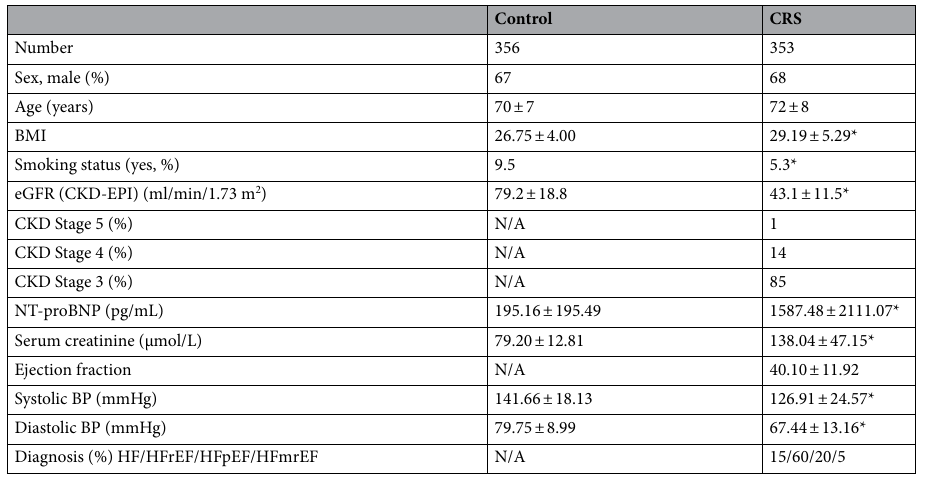
Table 1. Demographics and clinicopathological features characterizing the CRS cohort under investigation. Differences between controls and CRS have been evaluated by the Mann–Whitney U test (for continuous variables) or Chi-Square test (for categorical variables) and are marked with * when P < 0.05. Data are presented as mean ± standard deviation (s.d.) or number (%). BMI: body mass index; eGFR: estimated glomerular filtration rate; CKD-EPI: Chronic Kidney Disease Epidemiology Collaboration; CKD Stage 5: 0–15 ml/min/1.73 m 2 ; CKD Stage 4: 15–29 ml/min/1.73 m 2 ; CKD Stage 3: 30–60 ml/min/1.73 m 2 ; NT-proBNP: N-terminal pro b-type natriuretic peptide; BP: blood pressure; HF: heart failure; HFrEF: heart failure with reduced ejection fraction; HFpEF: heart failure with preserved ejection fraction; HFmrEF: heart failure with mid-range ejection fraction; N/A: not